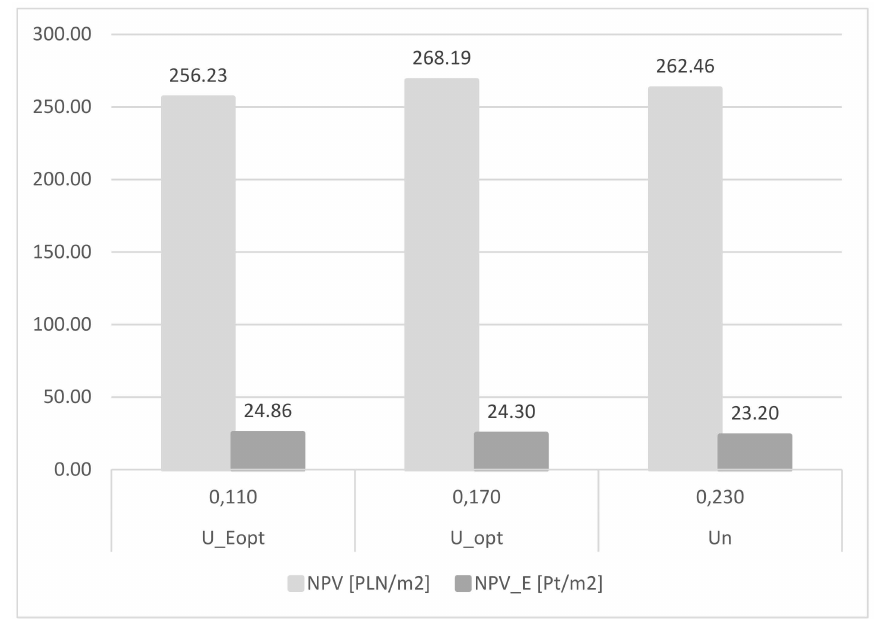
Figure 2. NPV and NPV E values depending on U for variant CHB-CGB-MW and climate zone